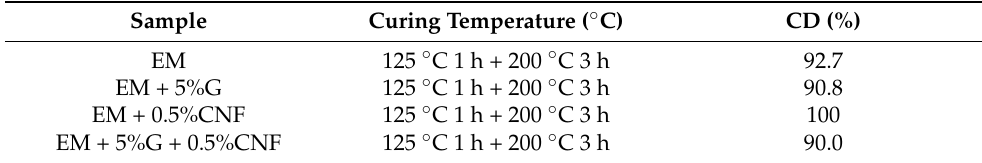
Table 2. CD values of the epoxy samples isothermally